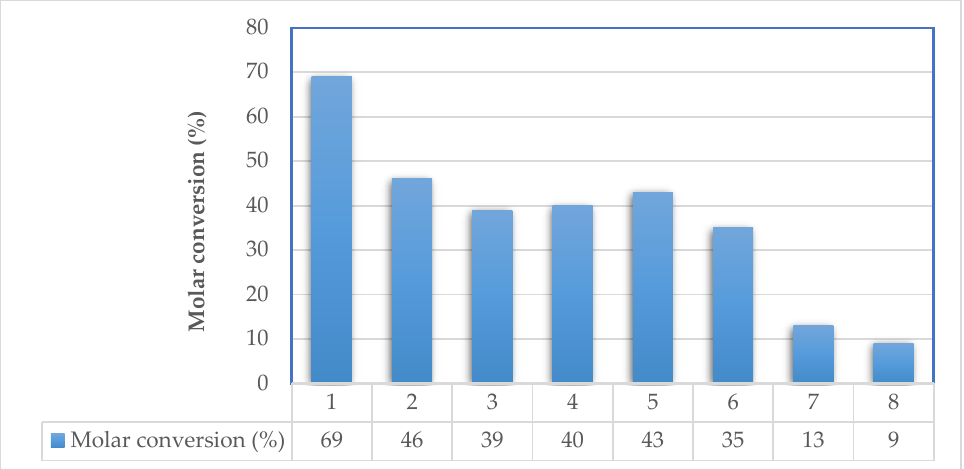
Figure 5. Repeated batch of catalytic reaction using Cu(II)-13a on S1.